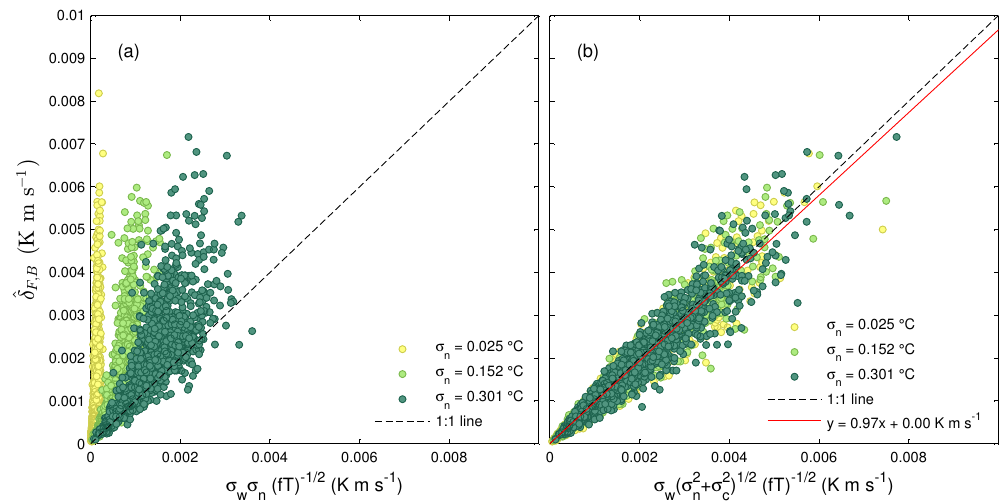
Figure 8. Error estimate calculated based on the Billesbach (2011) method ( ˆ δ F,B , Eq. (17) in this study) plotted against flux uncertainty caused by instrumental noise ( a ) and a combination of noise and signal variances ( b ). If the method would estimate purely the instrumental noise, the points in (a) would follow 1 : 1 line. Instead, as predicted by Eq. (18), the points follow 1 : 1 line in ( b ). Sonic temperature data from the forest site were used with different level of noise added as shown in the legend.